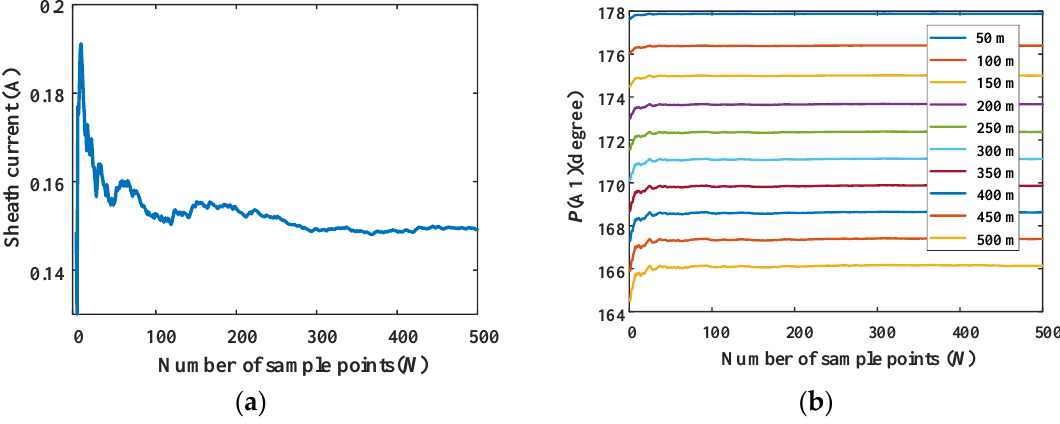
Figure 6. Mean convergence rate of MCS. ( a ) Normal operation. ( b ) Short-circuit fault. (2)